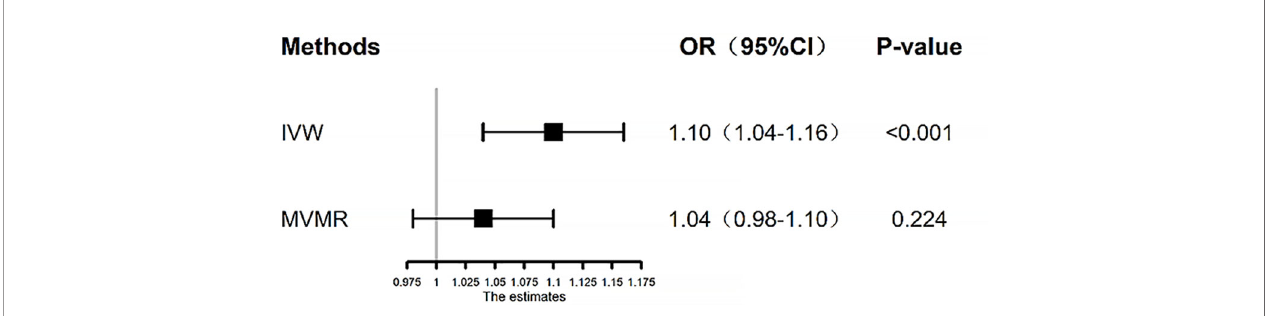
FIGURE 5 | Inverse-variance weighted (IVW) and multivariable Mendelian randomization (MVMR) estimates for genetic liability to T2DM on risk of endometrial cancer. The MVMR analysis adjusts for the associations of the genetic instruments with fasting insulin. The black box represents the effect estimates, and the black error line represents the 95% CI. IVW, inverse-variance weighted; OR, odds ratio; T2DM, type 2